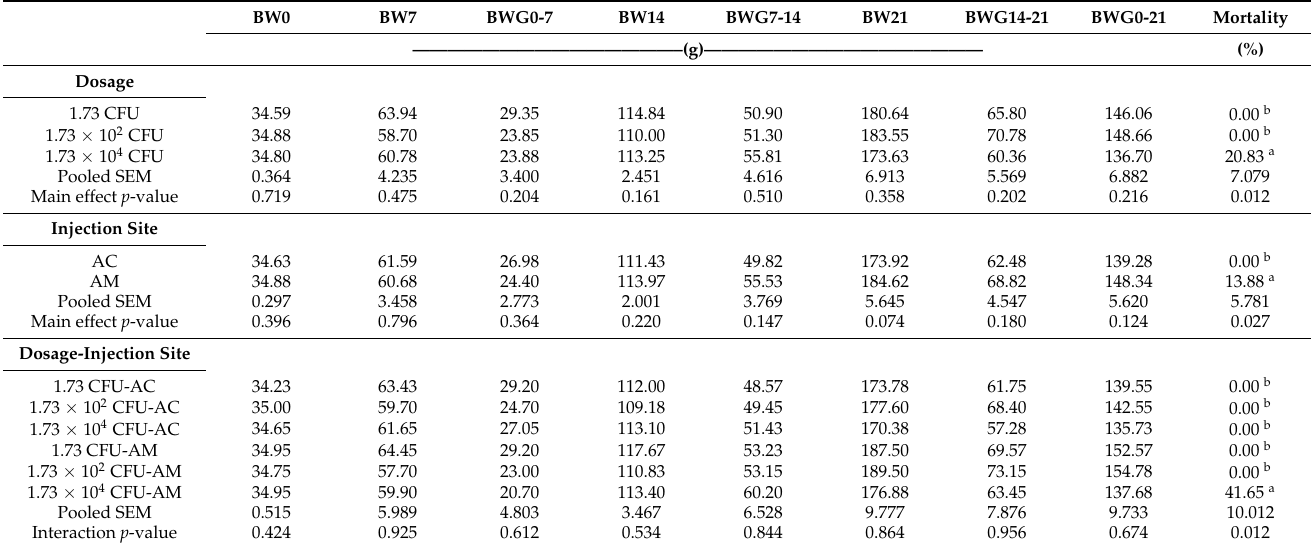
Table 9. Main and interaction means of body weight ( BW ) at 0 ( BW0 ), 7 ( BW7 ), 14 ( BW14 ), and 21 ( BW21 ) days ( d ) posthatch; BW gain ( BWG ) between 0 and 7 ( BWG0-7 ), 7 and 14 ( BWG7-14